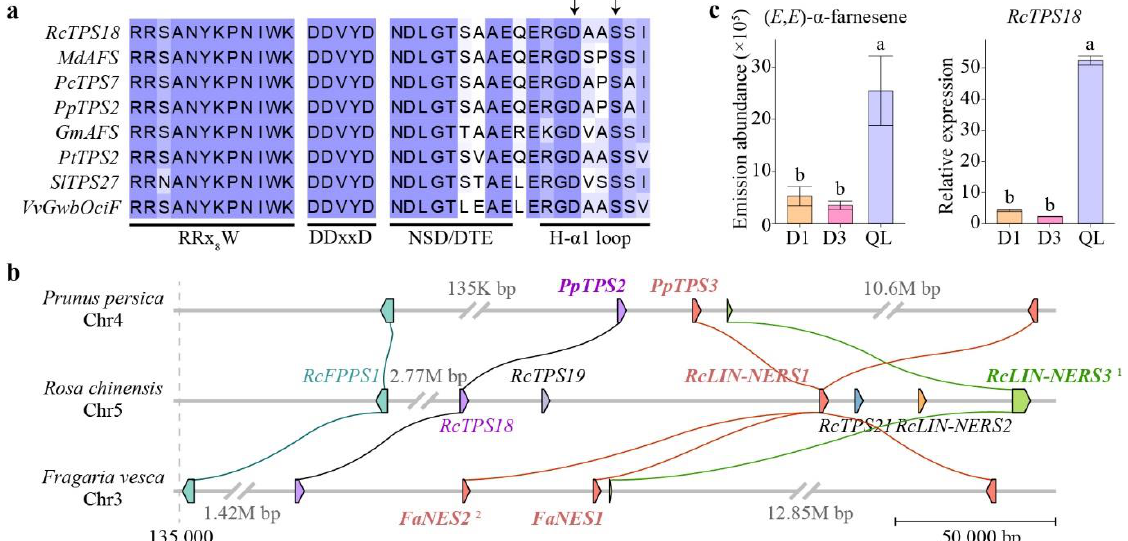
Figure 8. Functional analysis of RcTPS18 . ( a ) Protein sequence alignment of RcTPS18 and other ( E , E )- α -farnesene synthases. The arrows indicated the crucial residues for AFS activity. ( b ) Micro-synteny analyses among Rosa chinensis, Prunus persica and Fragaria vesca . The collinear gene pairs are linked in the same color. The characterized genes are in bold. 1: Characterized RcLIN-NERS3 with incomplete sequence. 2: The location of FaNES2 in the strawberry genome was revised based on its amino acid sequence. ( c ) Emission abundance of ( E , E )- α -farnesene and RcTPS18 expression levels in three rose samples. RhUBI2 was used as an internal control. QL: Rosa ‘Qinglian Xueshi’. Data are presented as the mean ± standard error ( n = 3). Different lowercase letters indicate statistically significant differences (ANOVA test, p < 0.05).